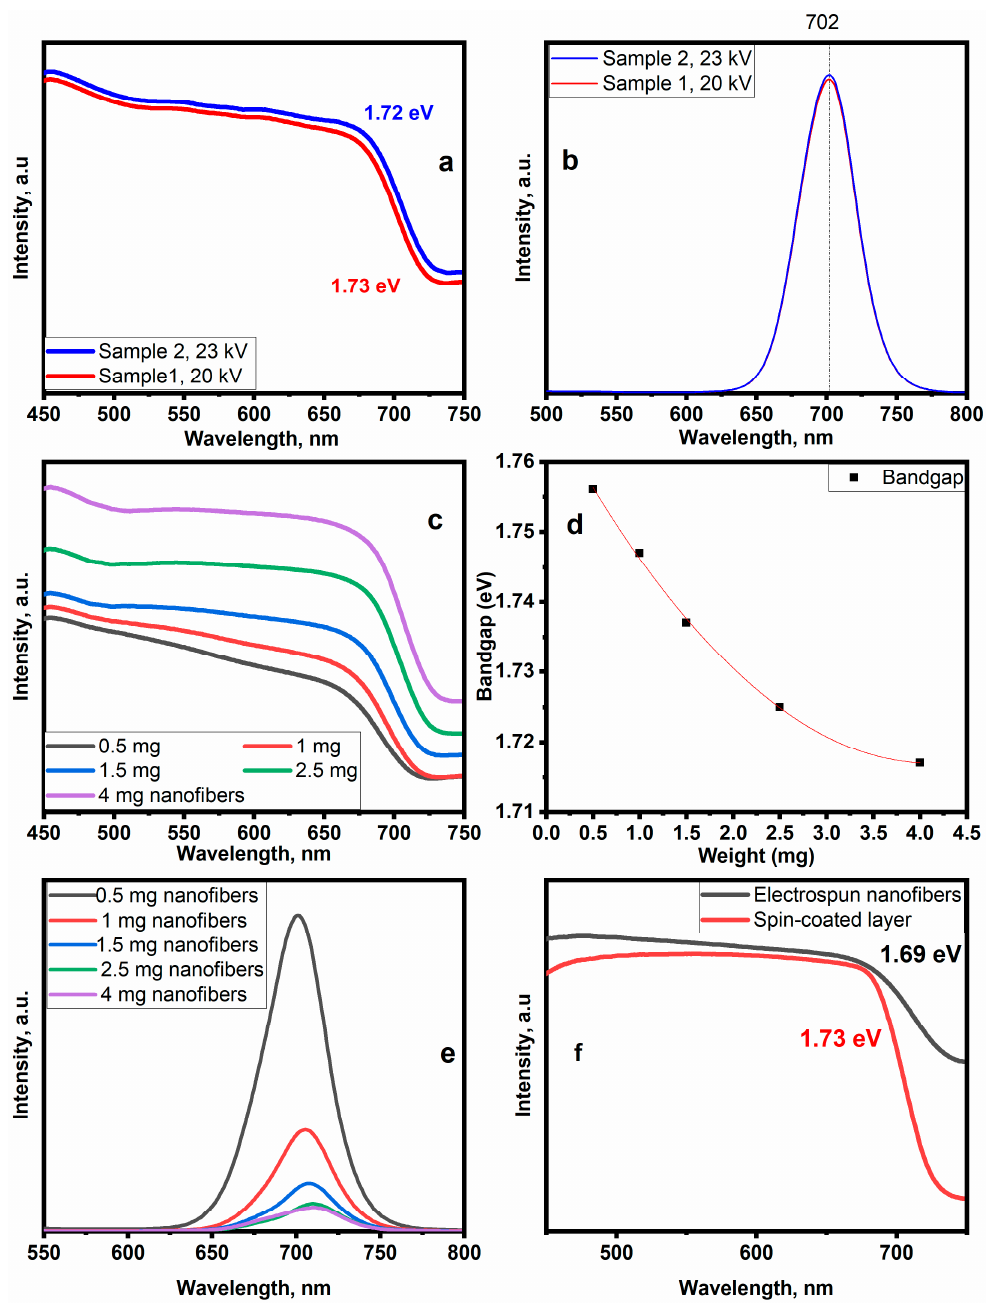
Figure 5. ( a ) light absorption and ( b ) PL spectra of samples 1 and 2, fabricated at 20 kV and 23 kV, respectively; ( c ) light absorption spectra of various nanofibers amounts on the glass (0.5, 1, 1.5, 2.5, 4 mg); ( d ) a bandgap-thickness relationship; ( e ) a PL-thickness relationship; ( f ) Light absorption spectra of a spin-coated layer and nanofibers for the same amount of material on the substrate. Nanofibers were fabricated at: voltage: 20 kV, distance: 150 mm, needle diameter: 0.42 mm, feed rate: 0.1 mL/h, planar collector; the spin-coated layer was fabricated at 6000 rpm for 60 sec.